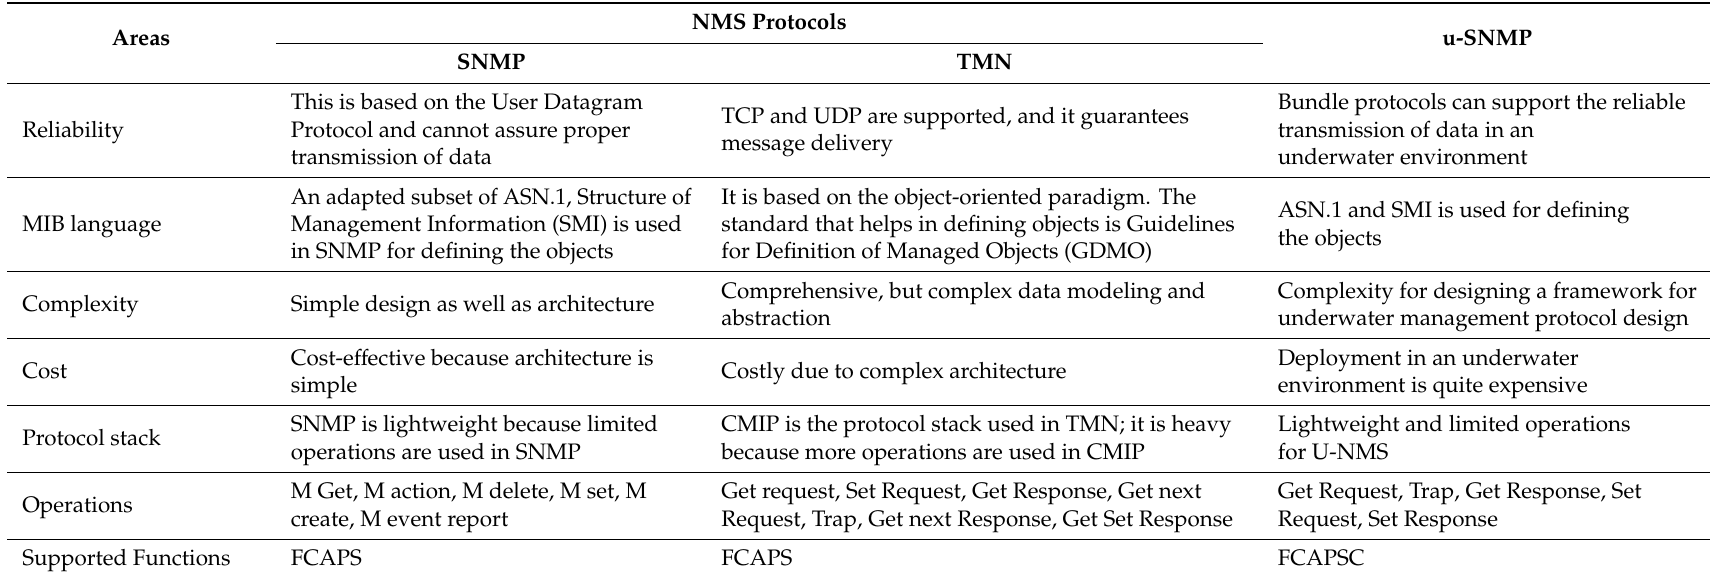
Table 4. Comparison between network management protocols of NMS and U-NMS.